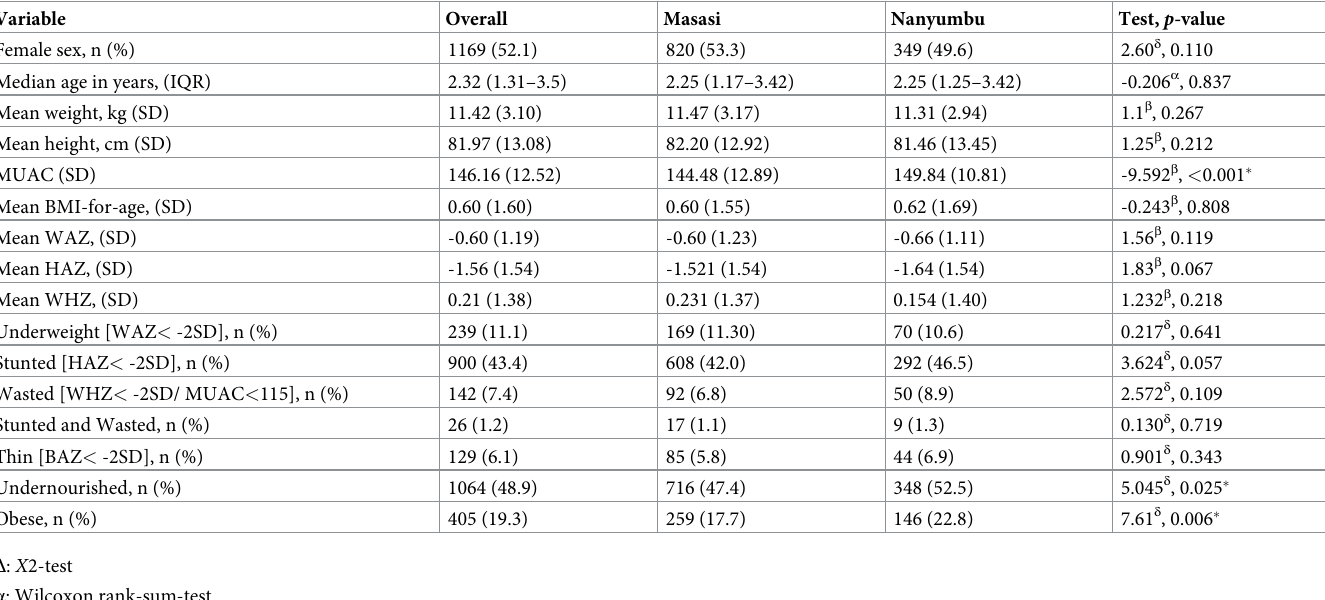
Table 1. Demographic and anthropometric characteristics of the study population by